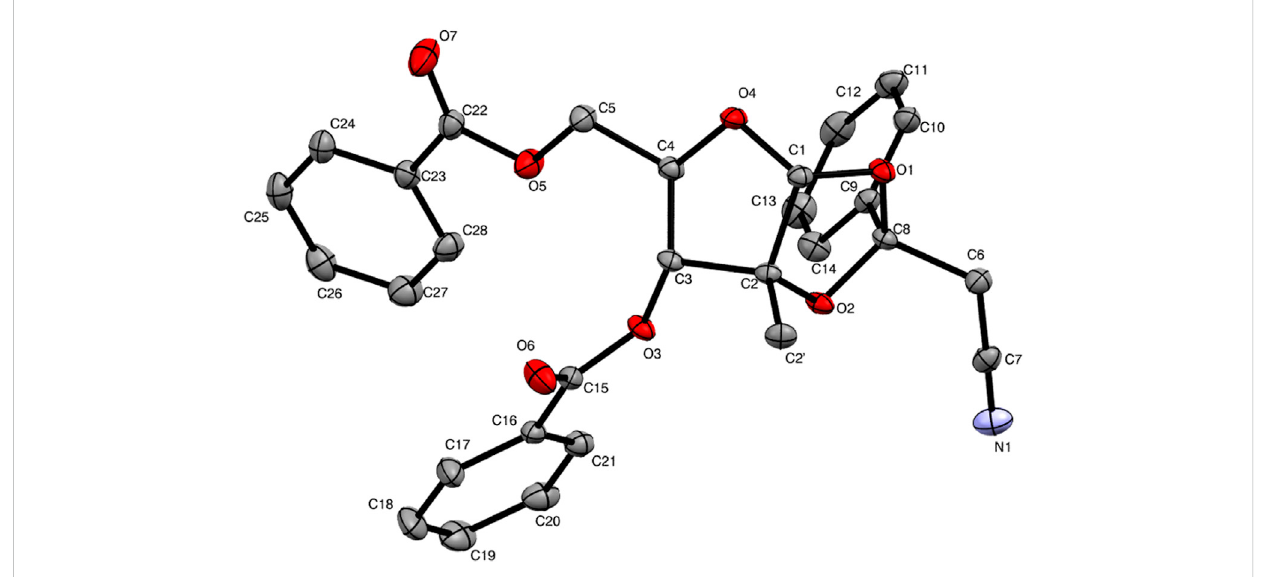
FIGURE 3 ORTEP view of compound 10